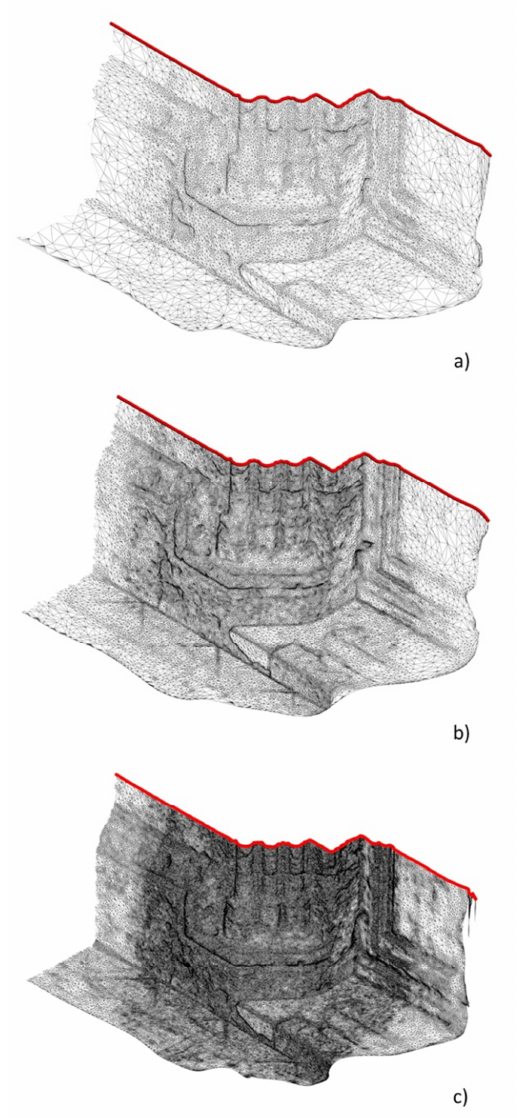
Figure 7. Assemini, progressive increase in the density of the mesh: Low 24506 faces, Medium 111126 faces, High 526628 faces